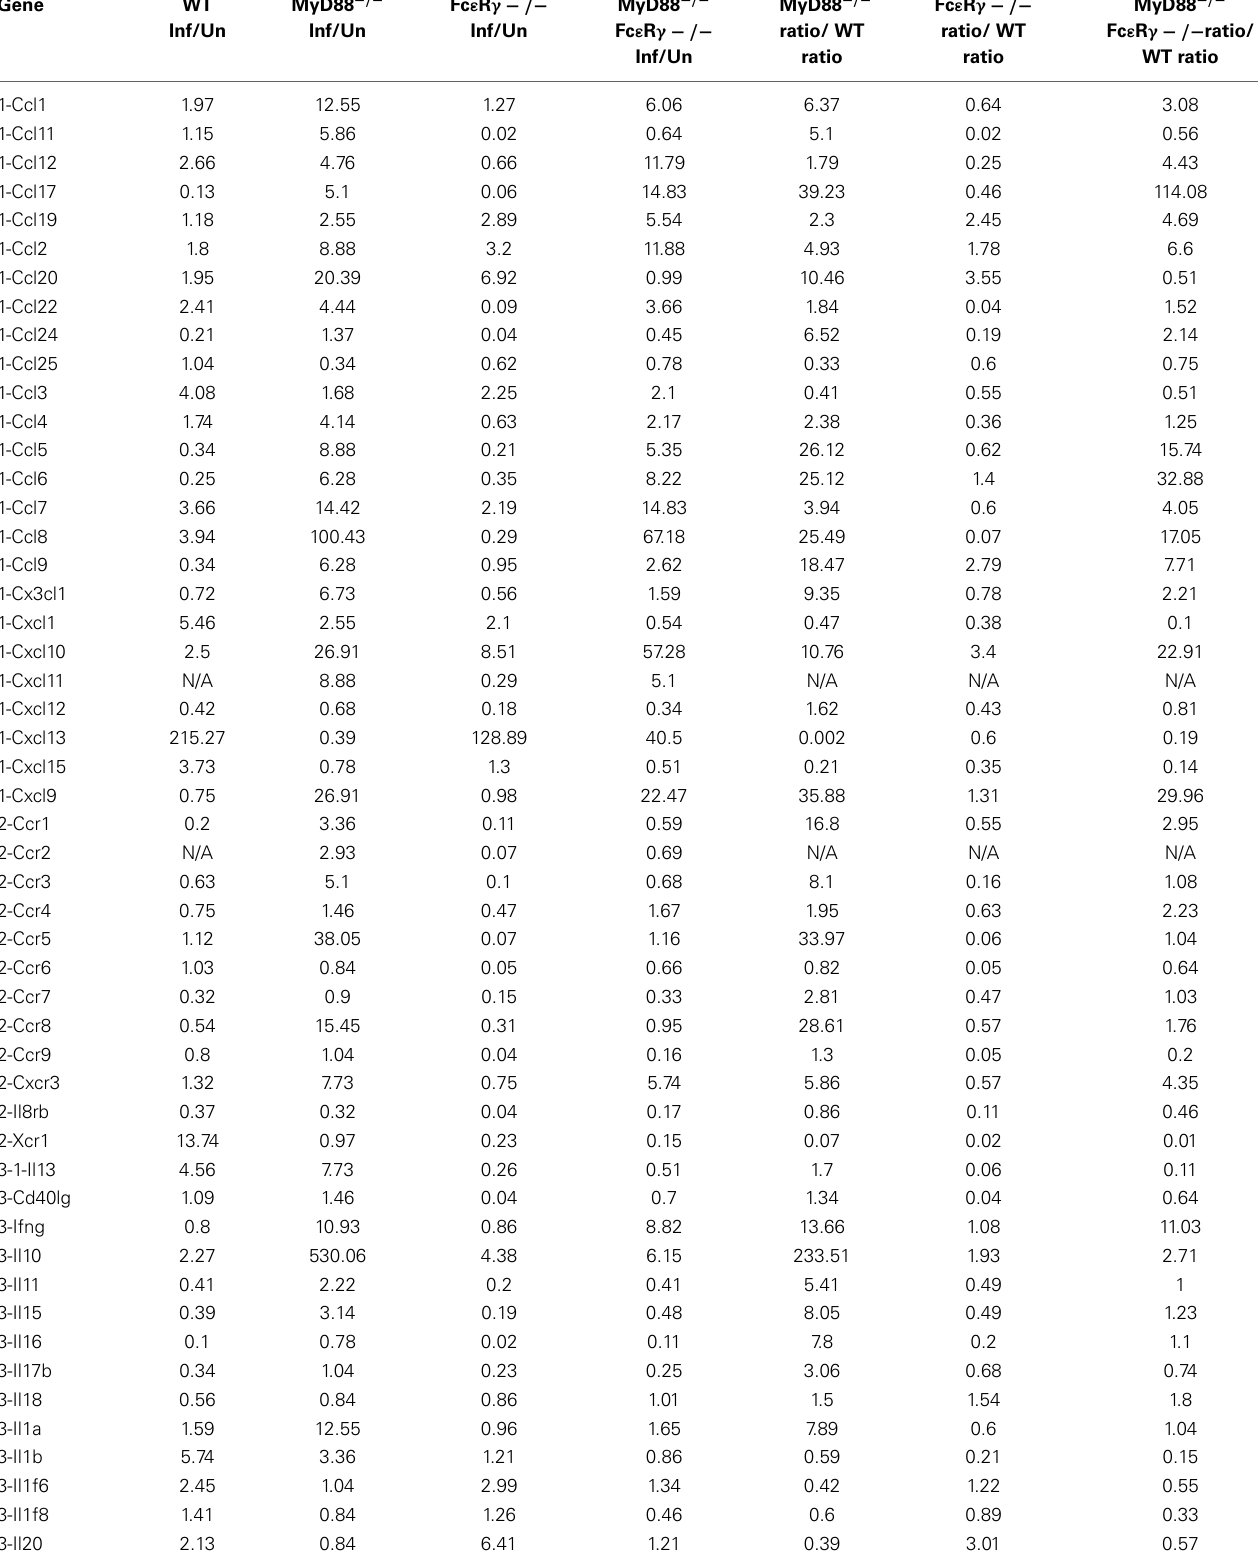
Table 3 | Microarray analysis of inflammatory genes expressed in mouse knee joints after B. burgdorferi infection. Gene